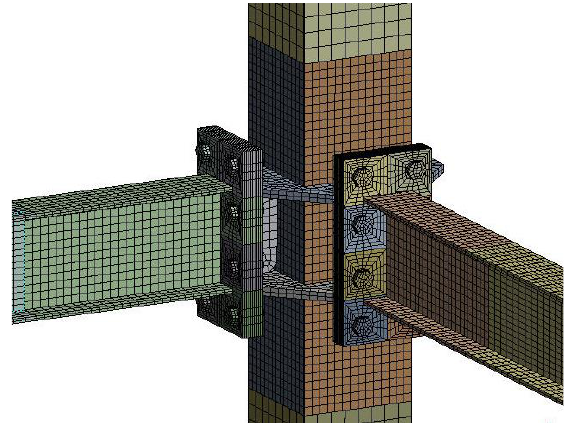
Figure 7. Meshing used in the numerical models.